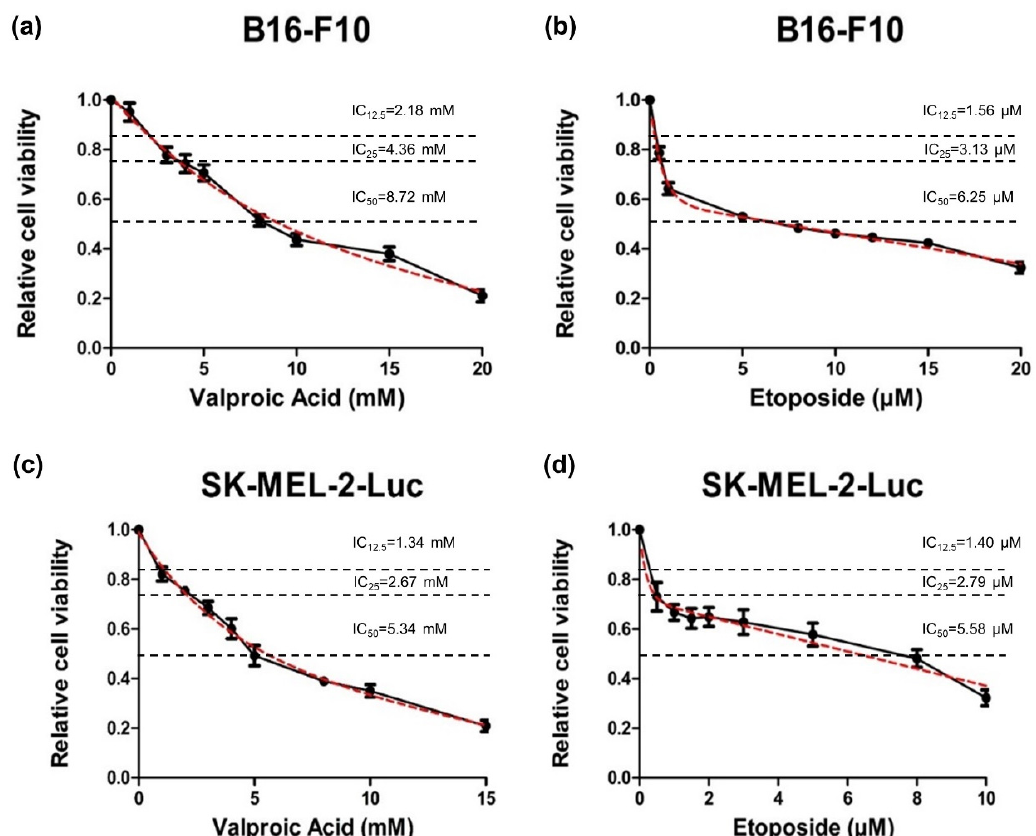
Figure 2 . Curve fitting analysis to determine the effective inhibitory concentrations of VPA and ETO. To obtain IC 50 s of VPA and ETO for subsequent experiments, exponential two-phase decay model (marked as dashed red line) was fitted to the dose-response curves (solid black line, representing data shown in Figure 1) of single treatment of ( a ) VPA (R 2 = 0.9531), or ( b ) ETO (R 2 = 0.9841) on B16-F10 cells; and single treatment of ( c ) VPA (R 2 = 0.9571), or ( d ) ETO (R 2 = 0.8415) on SK- MEL-2-Luc cells. The dose-response fitting curves were used to calculate the IC 12.5 , IC 25 and IC 50 as follow: Concentration of VPA in B16-F10 cells: IC 12.5 = 2.18 mM, IC 25 = 4.36 mM, and IC 50 = 8.72 mM; Concentration of ETO in B16-F10 cells: IC 12.5 = 1.56 μ M, IC 25 = 3.13 μ M, and IC 50 = 6.25 μ M. Concentration of VPA in SK-MEL-2-Luc cells: IC 12.5 = 1.34 mM, IC 25 = 2.67 mM, and IC 50 = 5.34 mM; Concentration of ETO in SK-MEL-2-Luc cells: IC 12.5 = 1.40 μ M, IC 25 = 2.79 μ M, and IC 50 = 5.58 μ M. The analysis was carried out by using GraphPad Prism 8 (GraphPad software, San Diego, CA, USA). The data are shown as means ± SEM of independent experiments in triplicate.